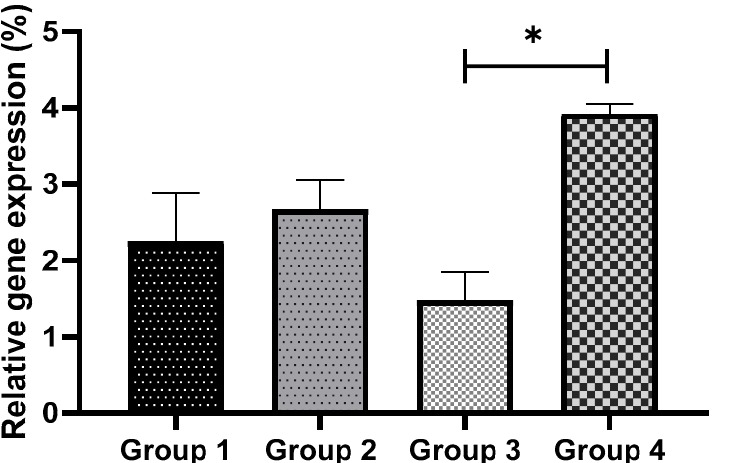
Figure 11. The effect of GSH supplementation on Gpx1 gene expression in non-vitrified and vitrified groups. Data are expressed as the means ± SEM. * indicates p < 0.05. Group 1 (GSH-free medium); Group 2 (GSH-supplemented medium); Group 3 (GSH-free medium with vitrification); Group 4 (GSH-supplemented medium with vitrification).